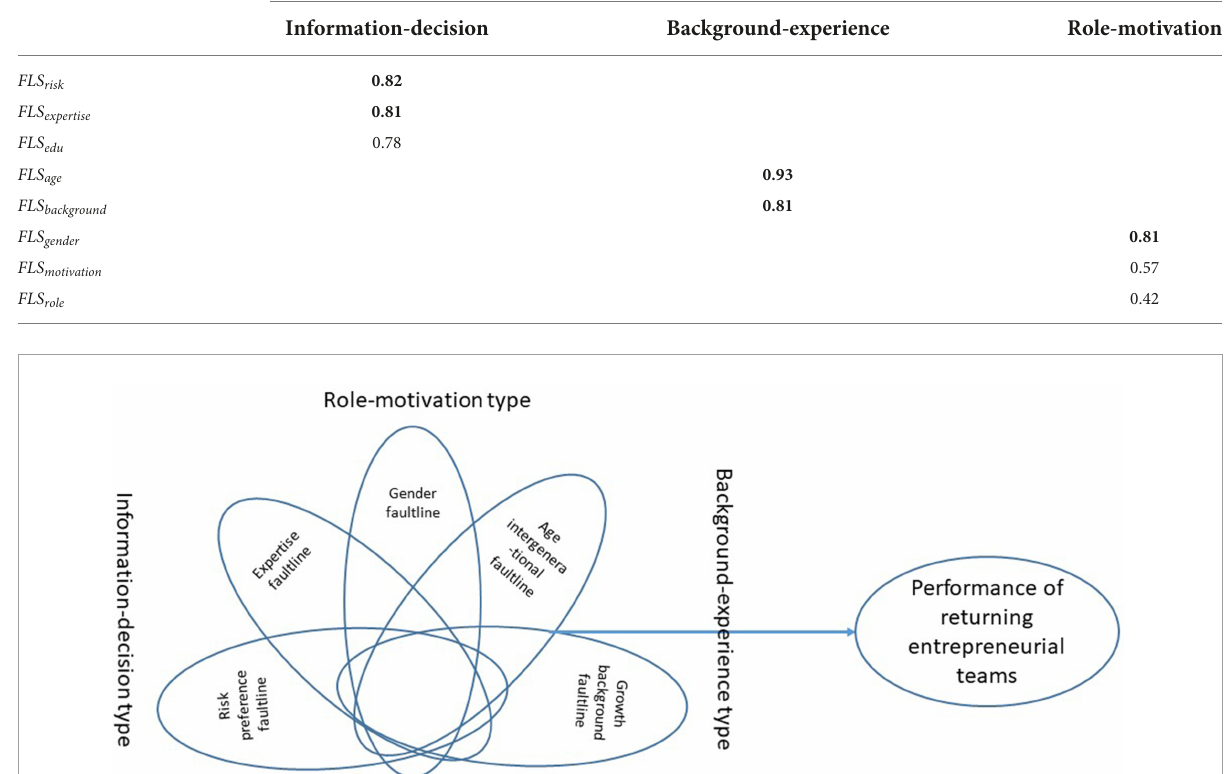
FIGURE1 Research